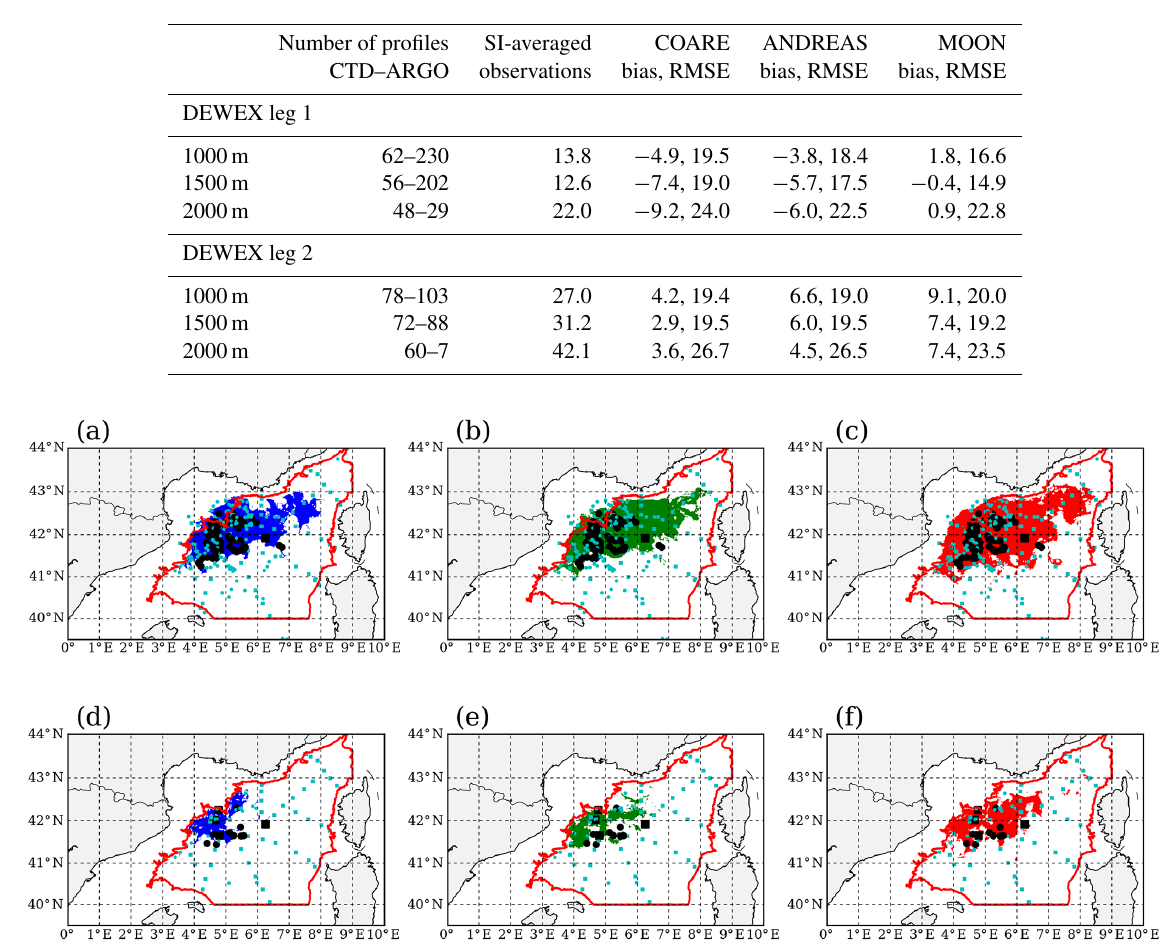
Figure 10. Coloured areas: extent of mixed patch zone computed for each simulation: (a, d) COARE, (b, e) ANDREAS and (c, f) MOON. The mixed patch is defined as the area where the stratification index, (a–c) at 1000m and (d–f) at 2000m, reaches 0 during simulation. Black squares correspond to the position of the CTD and ARGO mixed profiles: (a–c) SI(1000) = 0 and (d–f) SI(2000) = 0. Cyan points show the position of the CTD and ARGO stratified profiles: (a–c) SI(1000) > 0 and (d–f) SI(2000) > 0. Red line: convective area defined in Sect.